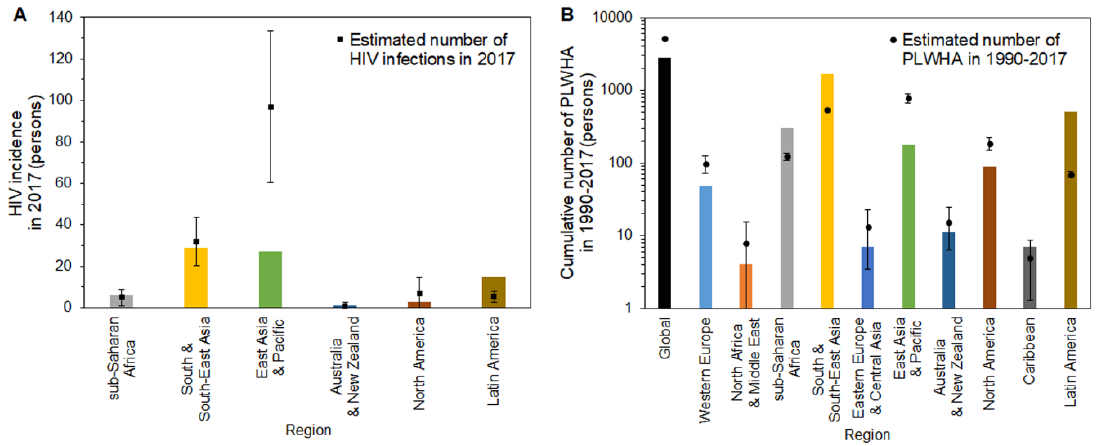
Figure 4. Comparison of observed and estimated HIV incidence and people living with human immunodeficiency virus (HIV)/acquired immunodeficiency syndrome (AIDS; PLWHA) among foreign residents in Japan. ( A ) Bars represent the observed incidence of HIV diagnoses in Japan in 2017, by region of the country of origin. Solid squares represent the estimated number of HIV diagnoses when using our model. ( B ) Bars represent the observed cumulative number of HIV infections and AIDS cases in Japan from 1990–2017, by region of the country of origin. Solid circles show the estimated cumulative number of HIV infections and AIDS cases by region in Japan when using our model. Whiskers extend to the upper and lower 95% confidence intervals. It should be noted that a common logarithmic scale is used on the vertical axis.